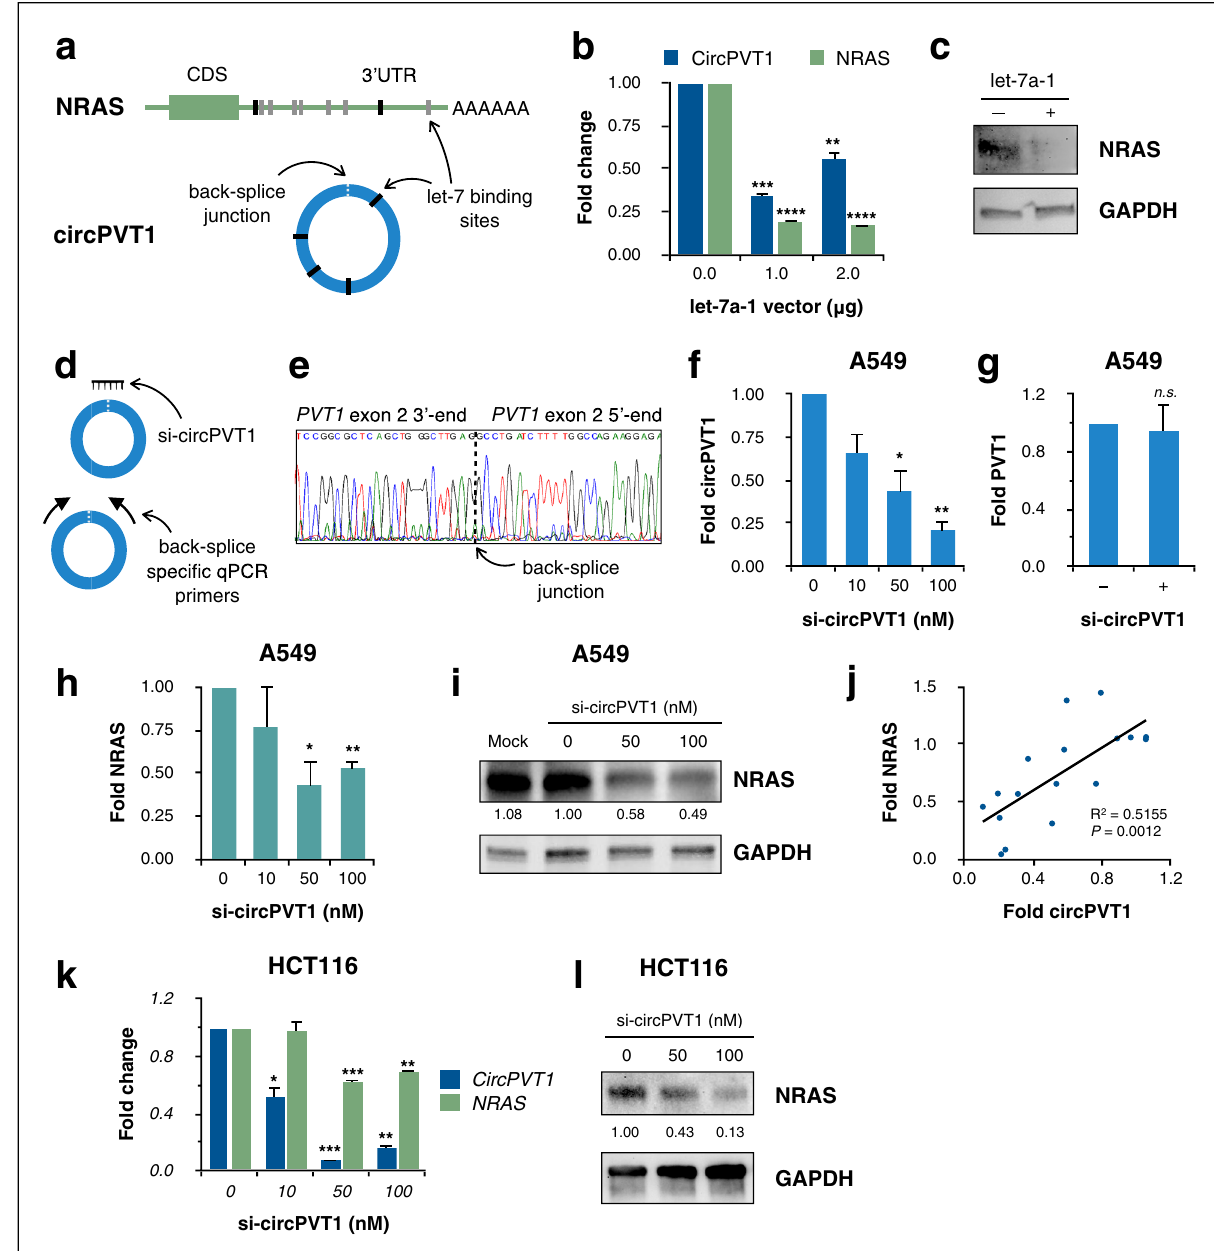
Figure 1. Let-7 and circPVT1 influence NRAS expression in A549 and HCT116 cells. ( a ) Schematic of let-7 binding sites predicted in silico in the NRAS 3 ′ UTR and in circPVT1. CDS, coding region. Black sites are canonical sites predicted in this study, while gray sites are additional noncanonical sites predicted previously 20 . ( b ) RT-qPCR measurements of endogenous circPVT1 and NRAS transcript levels in A549 cells transiently overexpressing let-7a-1. ( c ) Western blot for NRAS protein levels upon let-7a-1 overexpression. ( d ) Schematic of back-splice junction-specific siRNA for circPVT1 knockdown (si-circPVT1, top) and back-splice junction- specific RT-qPCR primers (bottom). ( e ) Sequence verification of the back-splice junction amplified by circPVT1 qPCR primers. ( f – h ) RT-qPCR measurements of endogenous ( f ) circPVT1, ( g ) PVT1, and ( h ) NRAS transcript levels in A549 cells upon circPVT1 knockdown. ( i ) Western blot for NRAS protein levels upon circPVT1 knockdown in A549 cells. ( j ) Correlation of fold changes in circPVT1 and NRAS expression as measured by RT-qPCR (n = 17 independent biological replicates). ( k ) RT-qPCR measurements of endogenous circPVT1 and NRAS transcript levels in HCT116 cells upon circPVT1 knockdown. ( l ) Western blots for NRAS protein levels upon circPVT1 knockdown in HCT116 cells. Data shown are fold changes (mean ± S.E.M. from at least three independent experiments) relative to the control set-up. n.s., not significant, *P < 0.05, **P < 0.01, ***P < 0.001, ****P < 0.0001, ANOVA with Dunnett’s post-hoc test. In ( c ) and ( i ), numbers indicate relative GAPDH- normalized densitometric quantity. Full-length blots are shown in Supplementary Figure